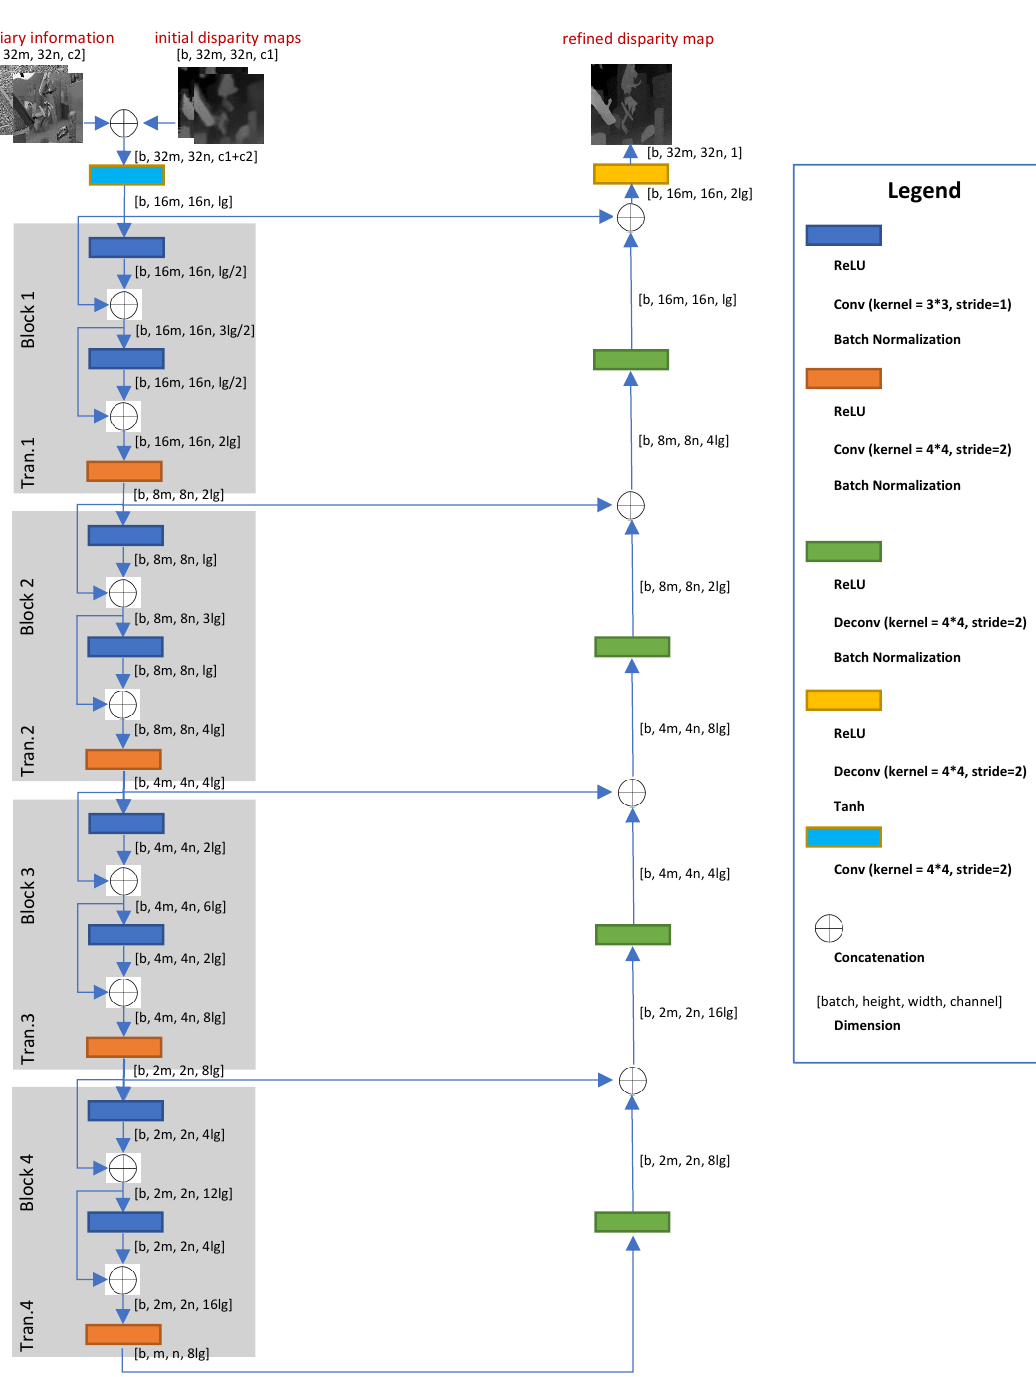
Please refer to Table 2 for the specific values in each experiment. Tip: Readers can deepen the refiner by symmetrically adding more dense blocks and deconvolution layer by themselves according to their own